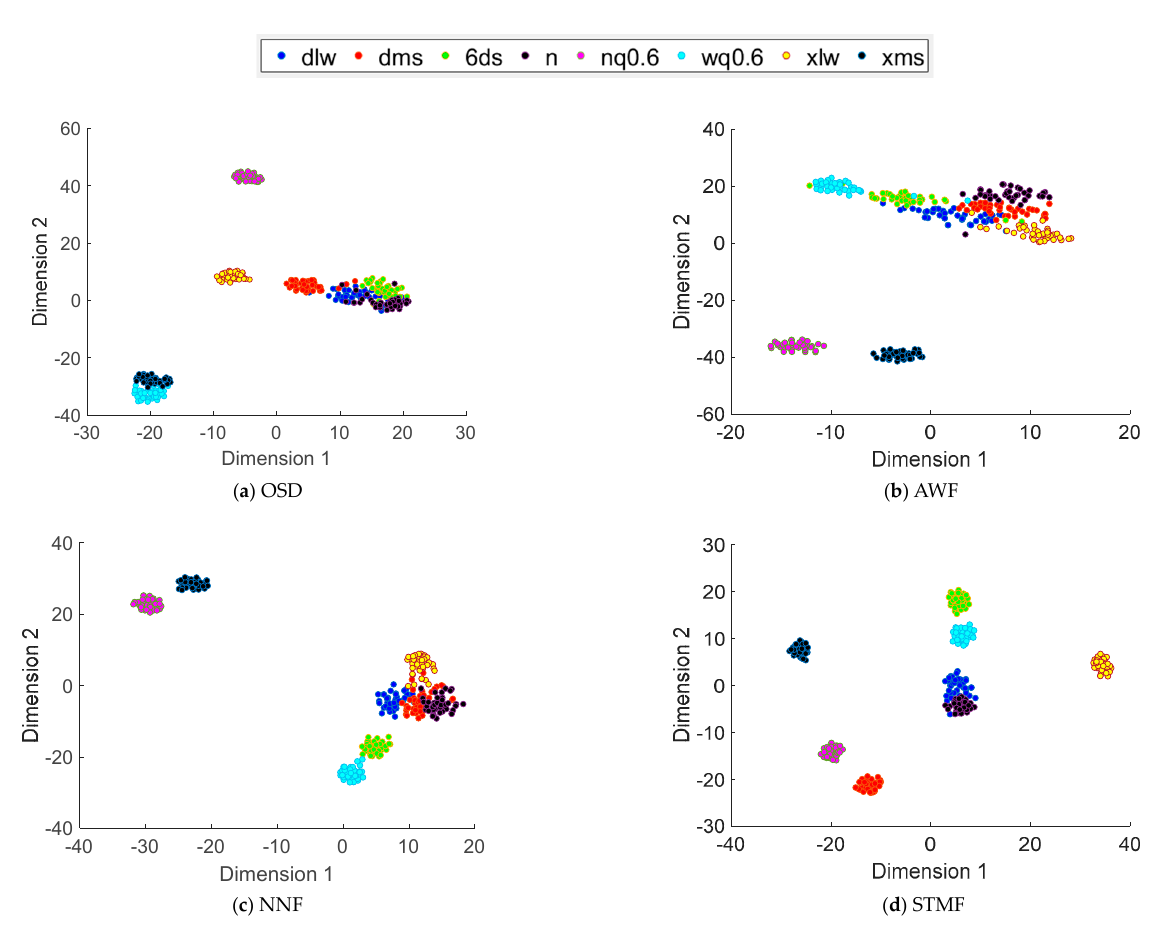
Figure 11. Comparison of eight types of fault classification results under 900 rpm. The classification effect of OSD is average, and several types of faults are clustered together under the working condition of 900 rpm. The aggregation degree of each fault in the AWF method is relatively poor, and the classification results of several faults are not very good; only xms and nq0.6 are separated from other faults. In NNF, the four types of fault classification results of planetary gear cracks (1.2 mm and 0.6 mm) and wear and bearing inner ring cracks of 0.6 mm are poor, all of which will affect the accuracy of the final fault diagnosis.